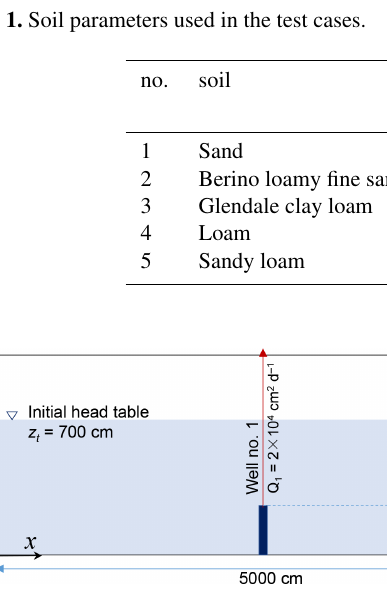
Figure 4. Schematic of the cross section for test case 2. Two pump- ing wells with screens of z = 0–200cm are located at x = 2500 and 5000cm. The pumping rates per unit width at well no. 1 and no. 2 are 2 × 10 4 and 1 × 10 4 cm 2 days − 1 , respectively.